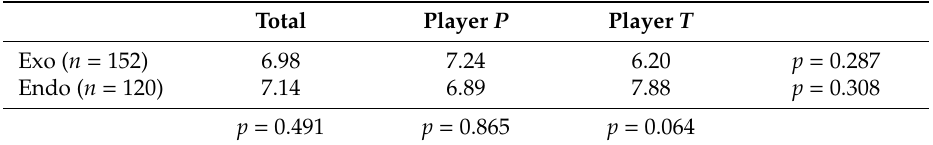
Table 2. Mean contribution in part I.